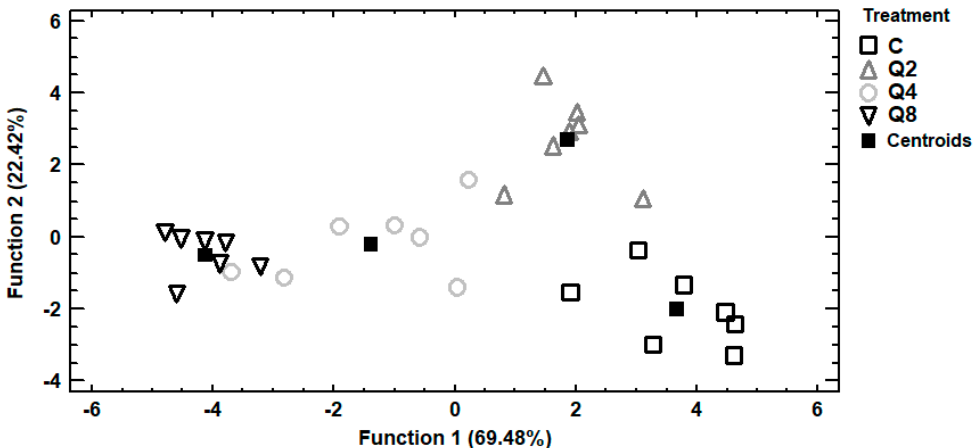
Figure 2. Discriminant plot separating egg albumen samples, according to the dietary treatment, based on trace and macro elements.